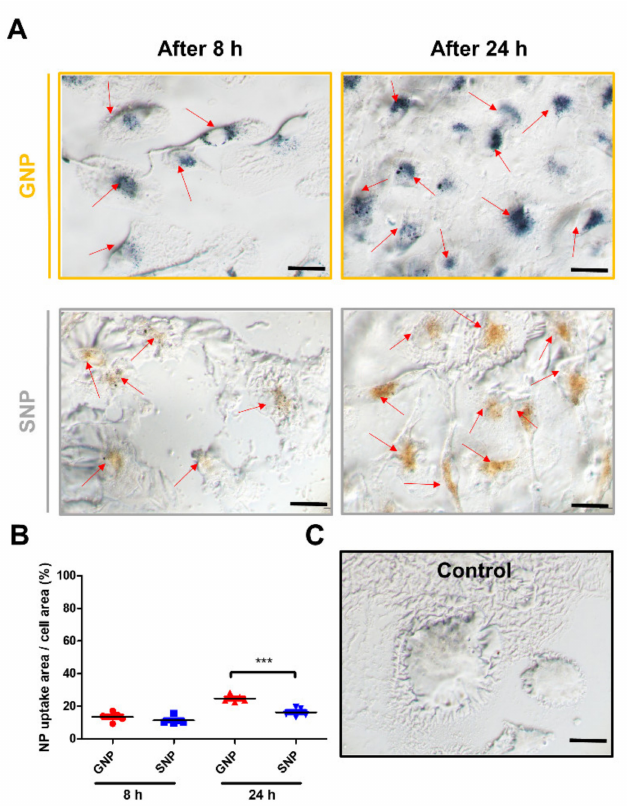
Figure 7. ( A ) Representative images of BMMs at 0.05 nM of GNPs or SNPs. Scale bars are 20 µ m. ( B ) Quantitative volumes are expressed as the mean ± SD ( n = 5 per group). “***” indicates a significant difference for which p < 0.001. ( C ) BMMs of the control group were cultured with CM. Scale bars are 20 µ